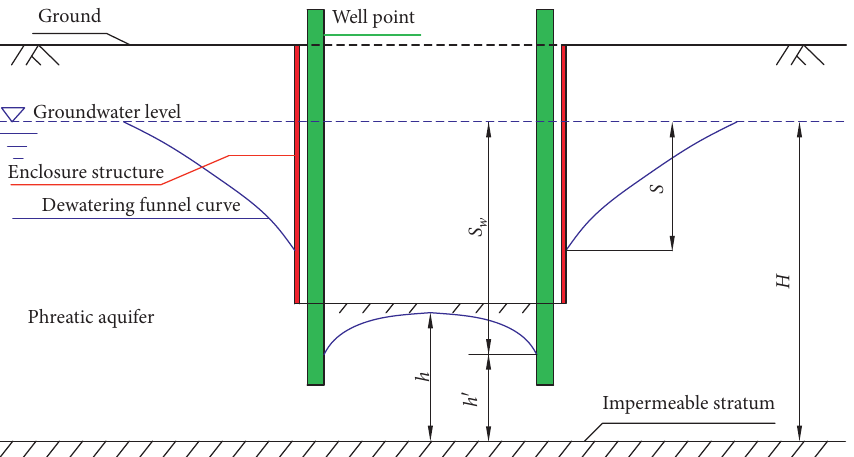
Figure 1: Schematic diagram of dewatering design in the open cut foundation pit.